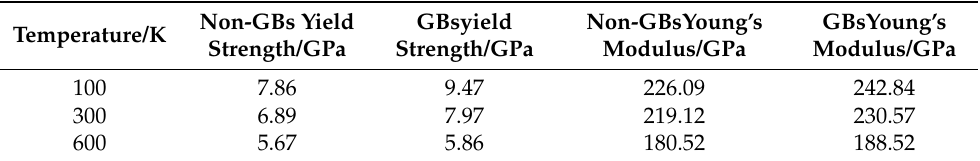
The CNA of Σ 3 GBs HEAs and non-GBs HEAs at different temperatures of 100, 300, there is an SF above the grain boundary. As the strain increases, the length of ISF